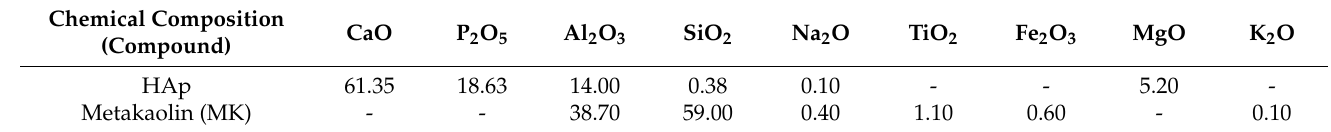
Table 2. Composition of HAp, kaolin and metakaolin.